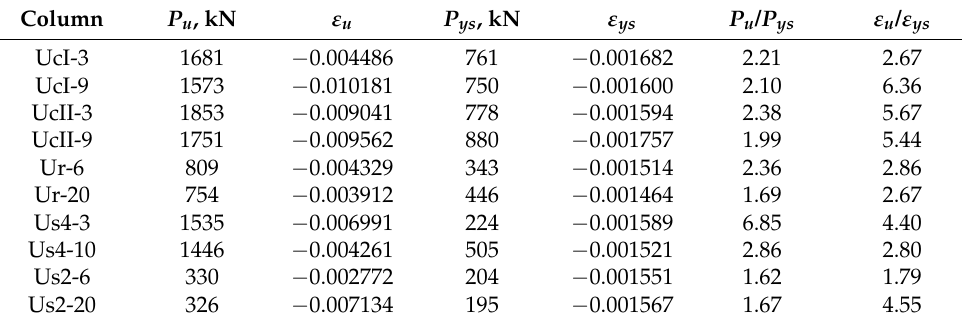
Table 3. Biaxial steel yielding and associated ductility in UHSC CFST